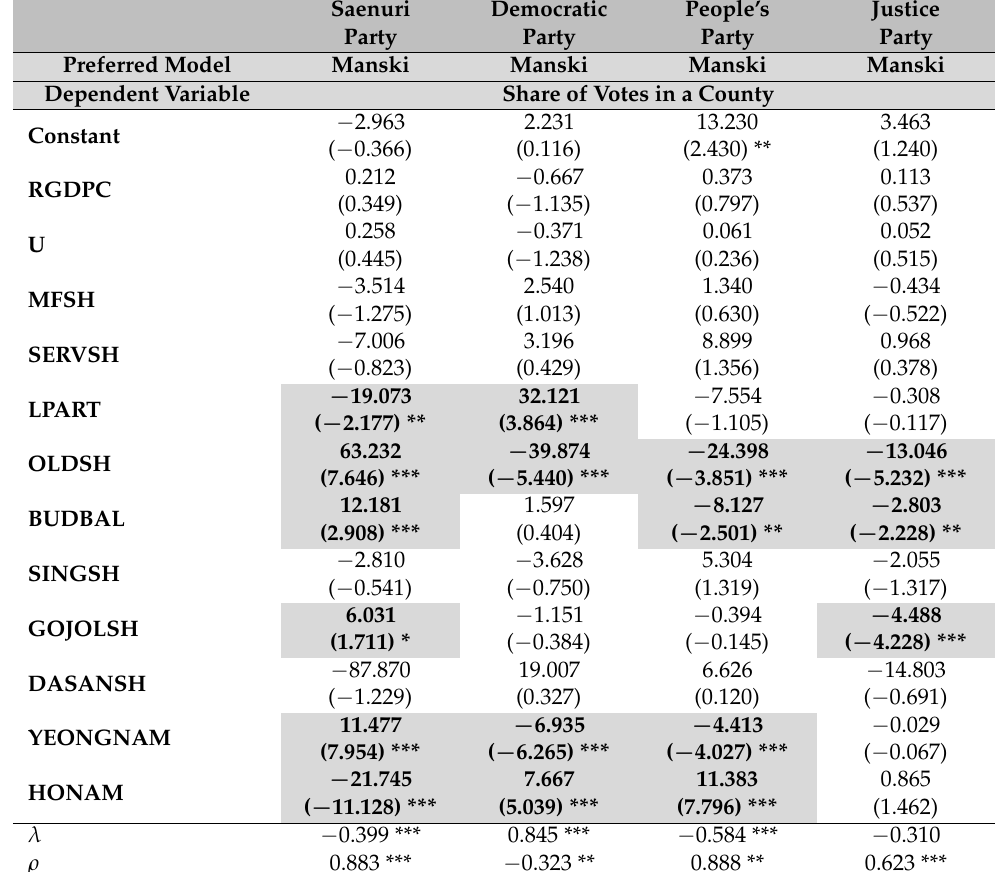
Table 4. Determinants of Koreans’ Voting Choice in the General Elections of